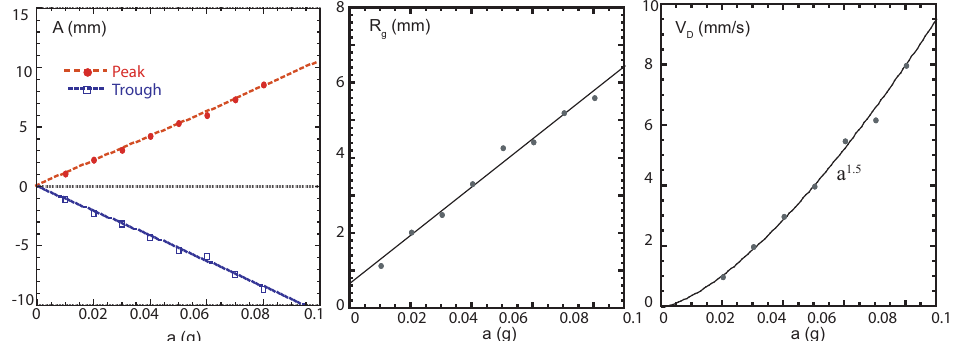
Figure 9. Experimental measurements of ( a ) the wave peak and trough; ( b ) the radius of the gyro-circle R g at the centre of the unit cell; and ( c ) the drift velocity of the fluid particles V D at the phase shift of φ = 90 ◦ , as a function of the paddle acceleration. Experimental parameters: 300 mm cavity, f = 3.8 Hz, a = 0.01 g to 0.08 g